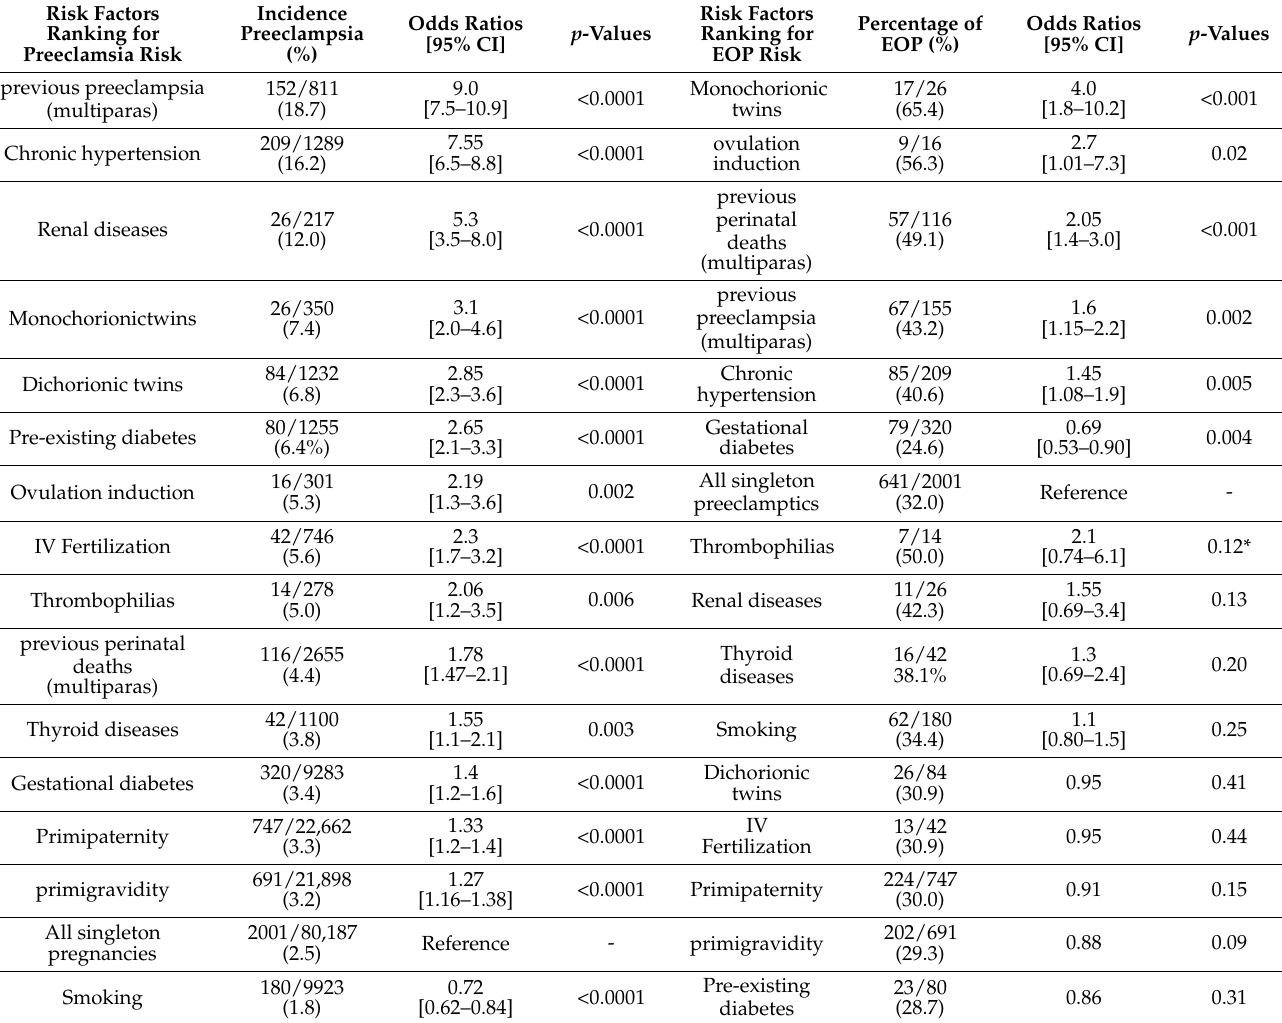
Table 2. Crude Odds ratios. On the left, ranking of preeclampsia risk (as compared with controls: singleton pregnancies without hypertension) from the highest risk to the lowest. On the right, ranking of EOP risk. From the highest risk to the lowest (Reference/control: percentage of EOP in singleton preeclamptics: